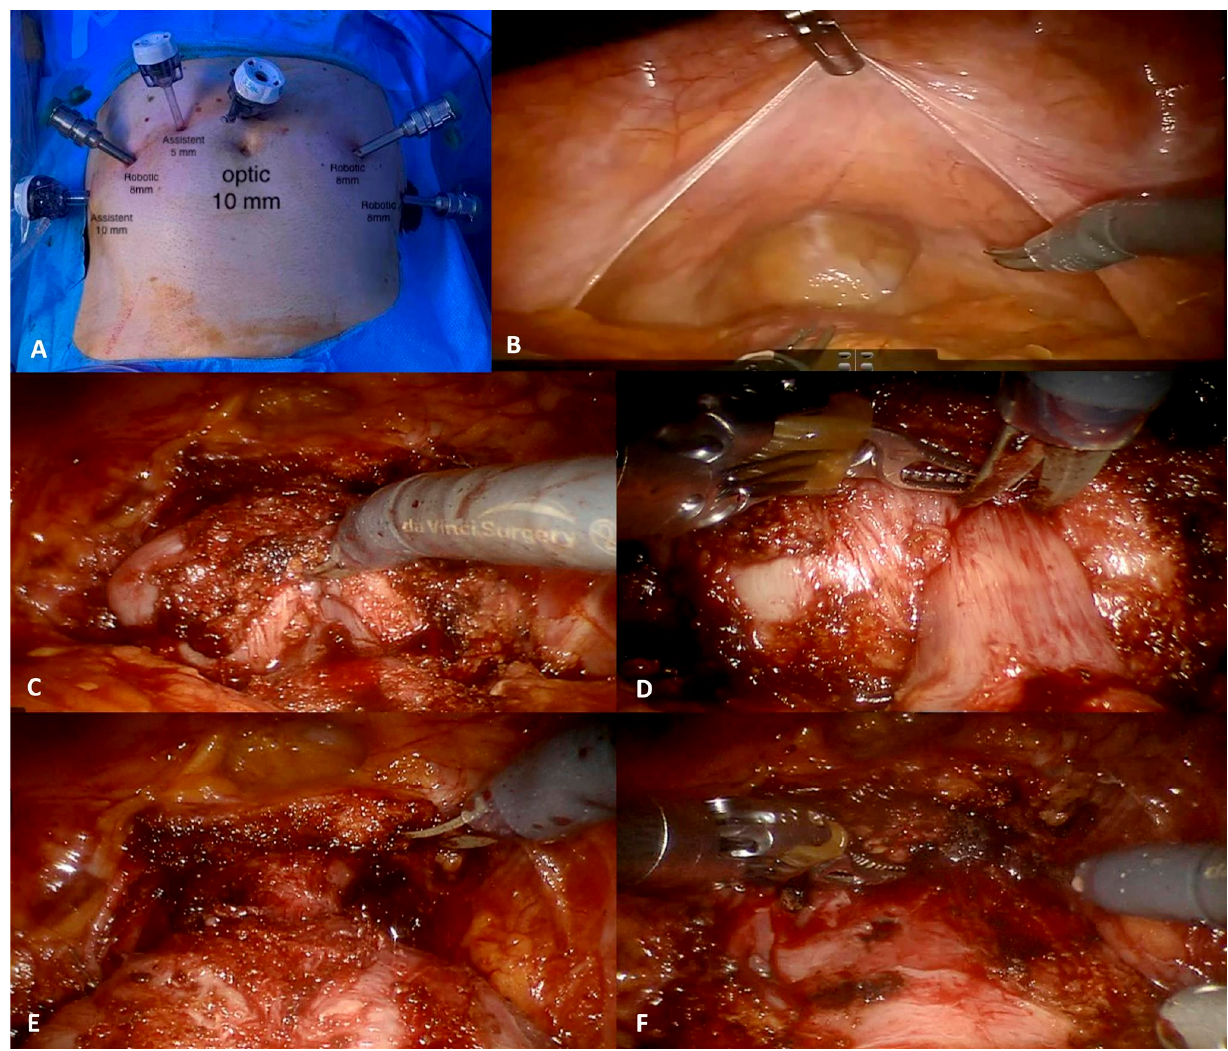
Figure 1. The University of Florence Technique for bladder-neck-sparing robot-assisted radical prostatectomy, step-by-step procedure. ( A ) Trocar mapping; ( B ) incision at the level of refection of peritoneal in recto-vesicle pouch (pouch of Douglas); ( C ) dissection of the vescico-prostatic margin; ( D ) Defining the funneled shape of the bladder neck transitioning to the prostatic urethra; ( E ) Isolation the urethra while preserving the maximum possible length; ( F ) urethrovesical anastomosis was performed using the Van Velthoven technique.